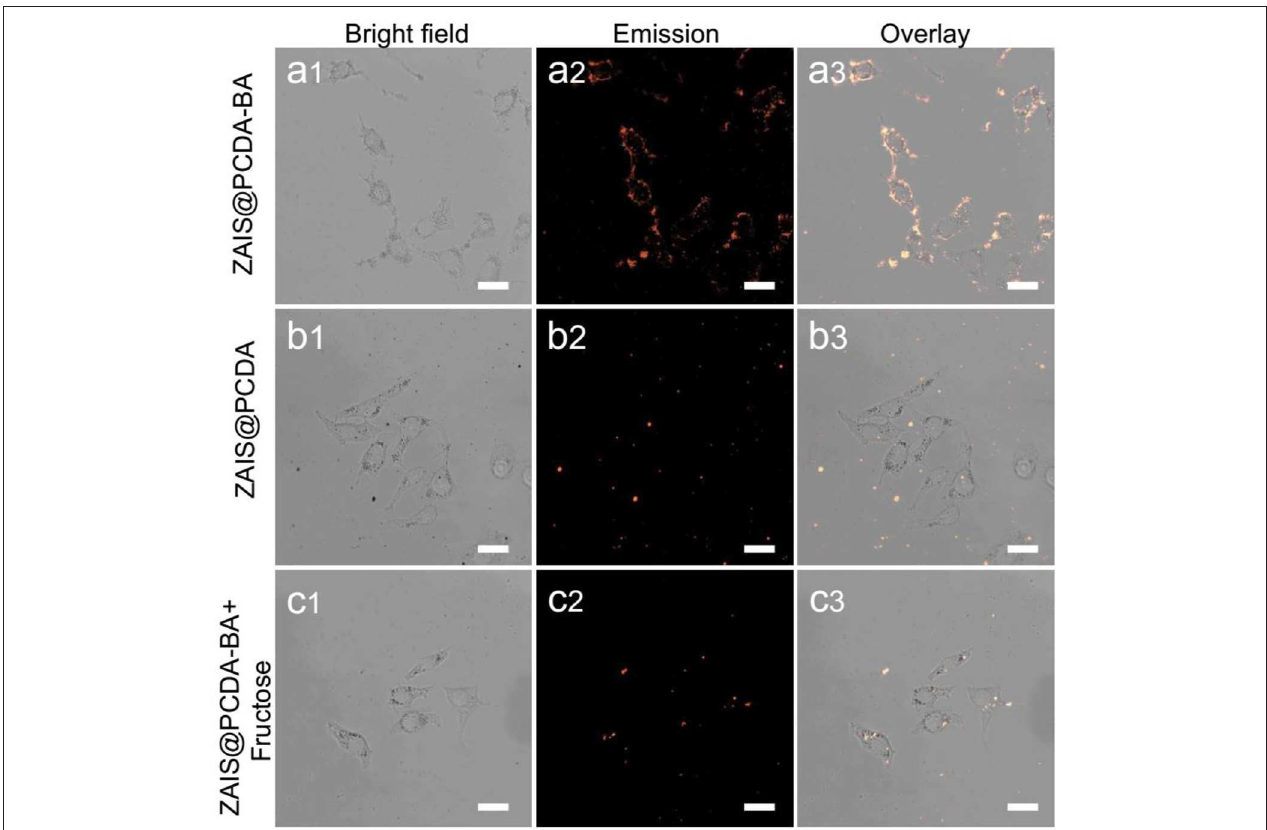
FIGURE 5 | Confocal luminescence imaging of HepG2 cells incubated with (a) ZAIS@PCDA-BA NCs, (b) ZAIS@PCDA NCs, and (c) ZAIS@PCDA-BA NCs in the presence of D-fructose (0.1M), respectively. Particles concentration: 300 µ g/ml. Irradiation: 488nm for ZAIS. Scale bar 25 µ m.